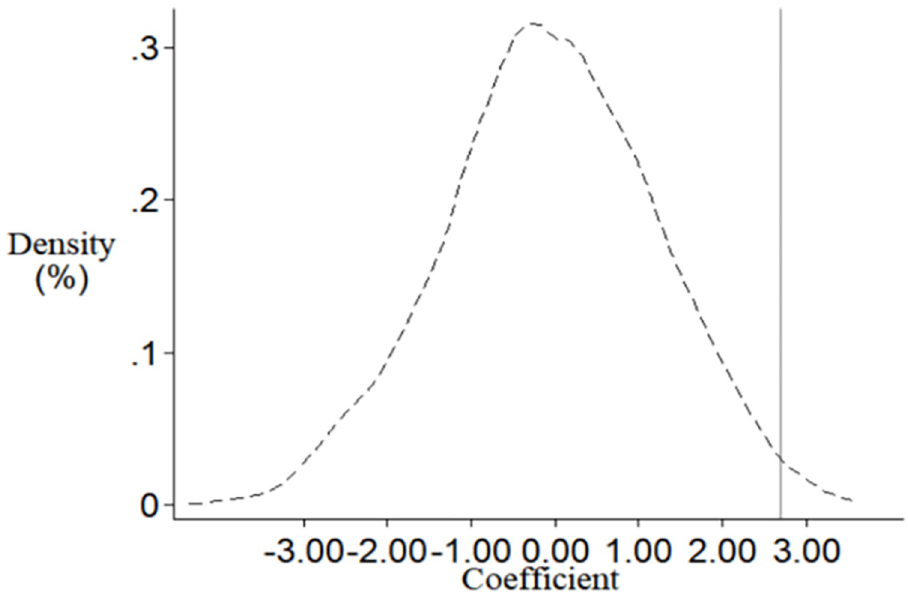
Fig 2. Placebo test based on randomly generated experimental